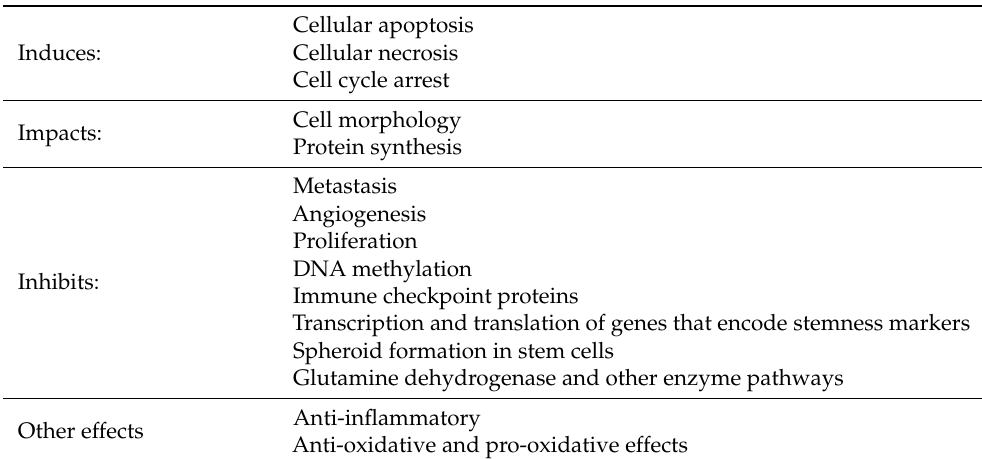
Table 2. Major effects of green tea catechins on cancer cells (not all